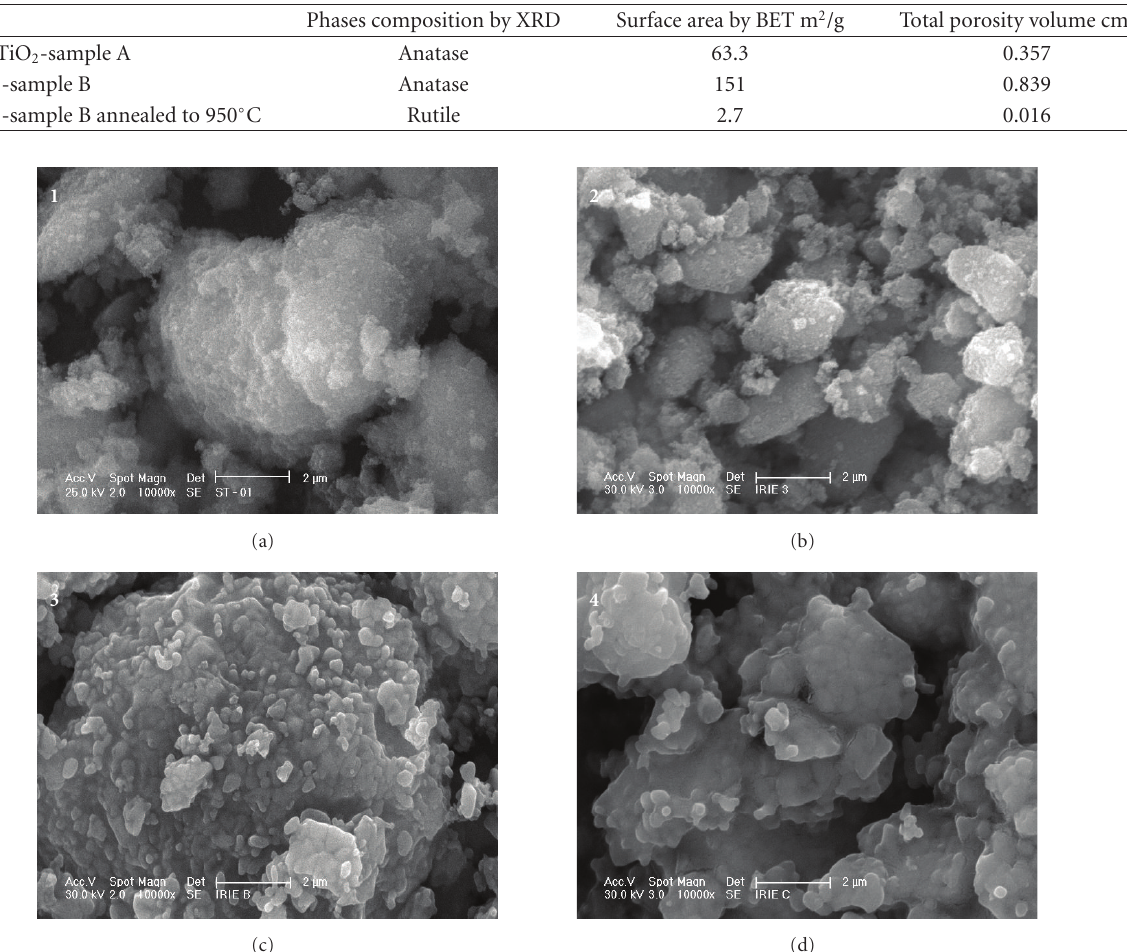
Figure 2: SEM micrographs of starting TiO 2 (sample A) and TiO 2- x N x (sample B) heated to various temperatures: (1) starting TiO 2 prepared from anatase ST 01, Ishihara Ltd., Japan, (2) TiO 2- x N x (sample B) prepared by heating sample A in a flow of NH 3 at 575 ◦ C/3h, (3) TiO 2- x N x (sample B) annealed at 800 ◦ C, and (4) TiO 2- x N x (sample B) annealed at 950 ◦ C.